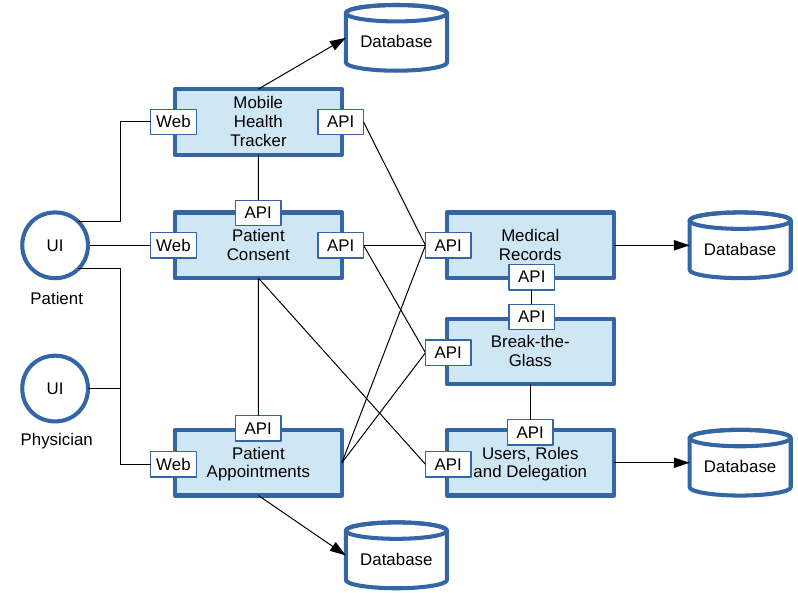
Figure 5. Authorization as a workflow in a healthcare